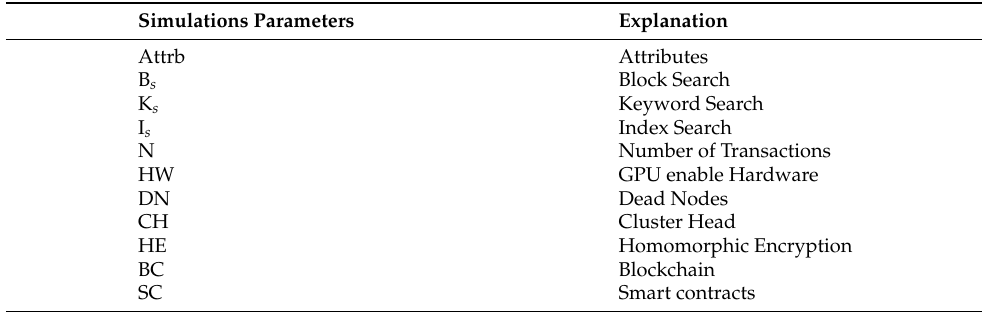
Table 3. List of Proposed